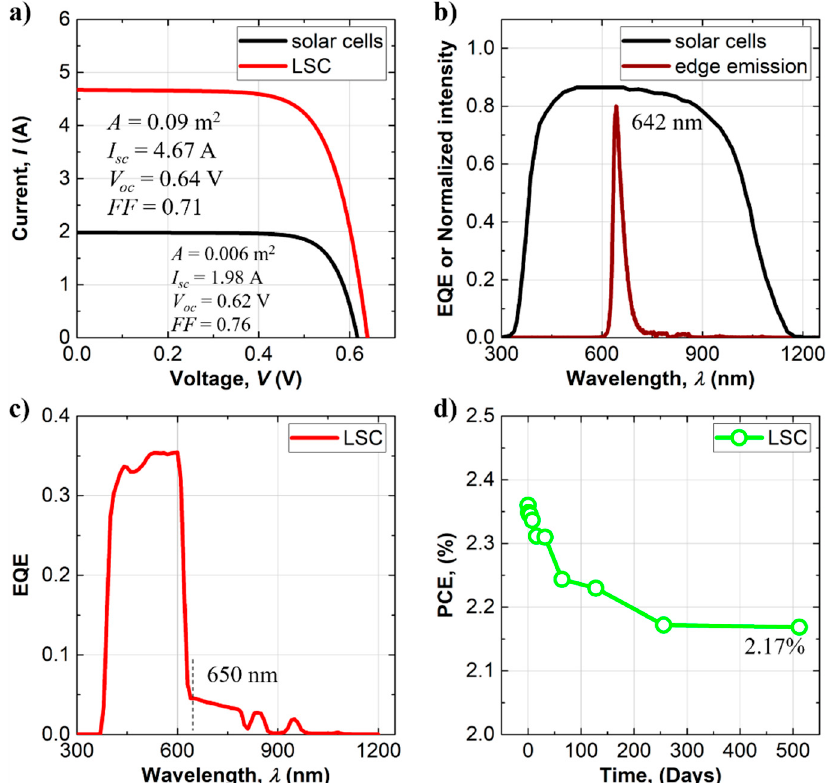
Figure 2. ( a ) I-V curves of the parallel-connected solar cells and the LSC, ( b ) edge emission spectrum of the luminescent waveguide (normalized to 0.8) and EQE of the solar cells, ( c ) EQE of the LSC, and ( d ) photostability of the LSC. ( d ) photostability of the